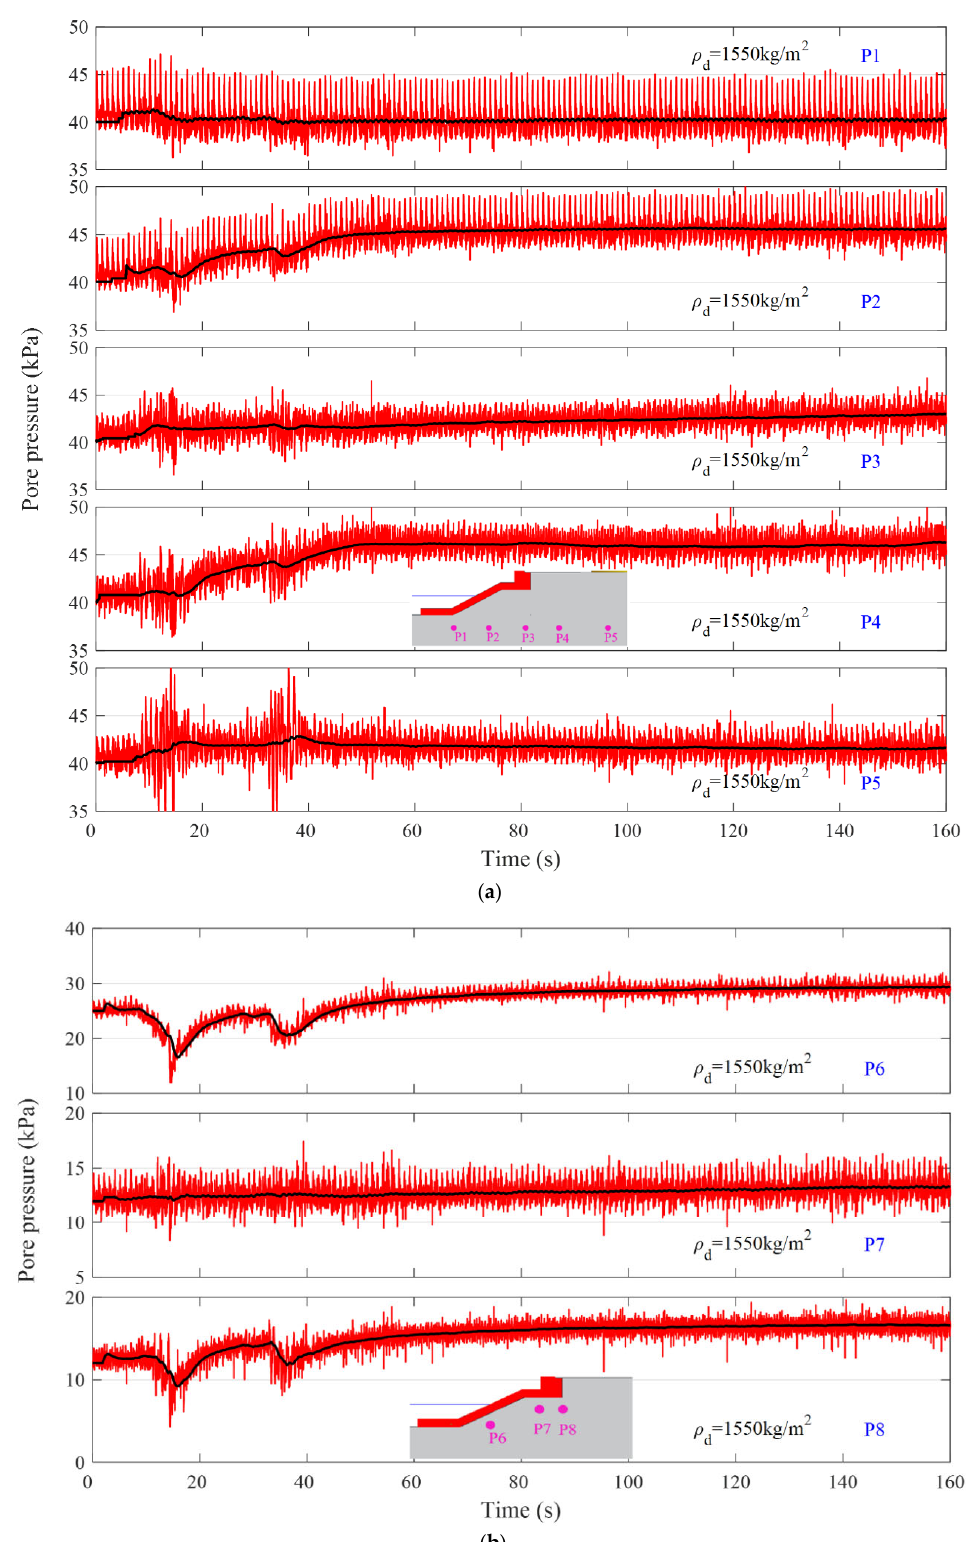
Figure 11. Dynamic responding of pore pressure at P1 to P8 in the coral sand foundation. ( a ) P1 to P5. ( b ) P6 to P8. To further evaluate whether the liquefaction occurs or not within the coral sand foun ‐ dation, the initial effective stress field of the physical model needs to be estimated. In this study, the numerical simulation software FssiCAS is utilized to estimate the initial effec ‐ tive stress within the physical model under the 50 g gravity environment. FssiCAS is a powerful FEM software in the fields of marine geotechnics and marine engineering geol ‐ ogy, available at https://www.fssi.ac.cn/download.html (accessed on 25 October 2022). The established finite element model and mesh discretization (hexahedron element) are illustrated in Figure 12a, where the total number of finite element elements is about 200,000. The boundary conditions applied are as follows: (1) The bottom of the model is fixed for displacements in x , y, and z directions, and the four lateral faces are fixed in horizontal. (2) The hydrostatic pressure of 50 𝜌𝑔ℎ ( h is the distance from a point on the surface of the coral sand foundation to the static water level (SWL)) is applied to the sur ‐ face of the coral sand foundation and revetment and ensuring that the effective stress on the surface of the coral sand foundation is zero. Since the simulation here is only to esti ‐ mate the initial effective stress, the elastic constitutive model is adopted for the coral sand foundation, breakwater and runway. The vertical effective stress distribution is shown in Figure 12b.